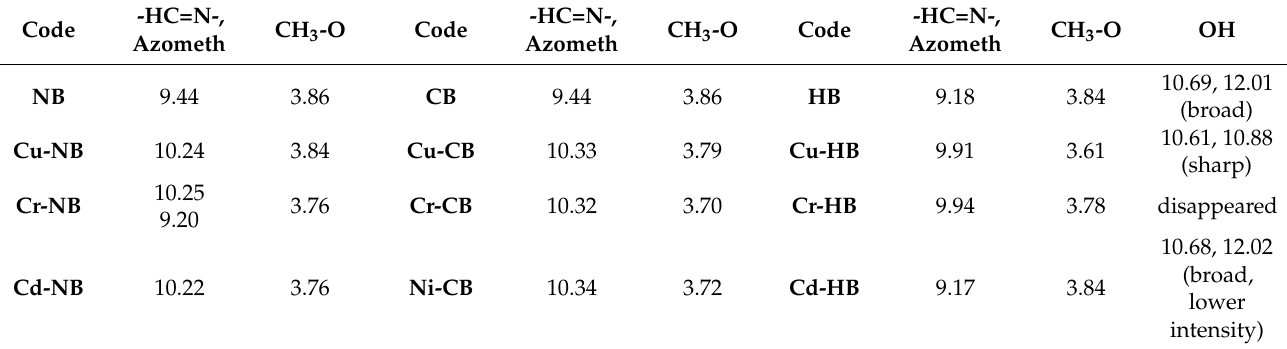
Table 5. Some 1 H-NMR peaks of NB, CB and HB and their metal complexes